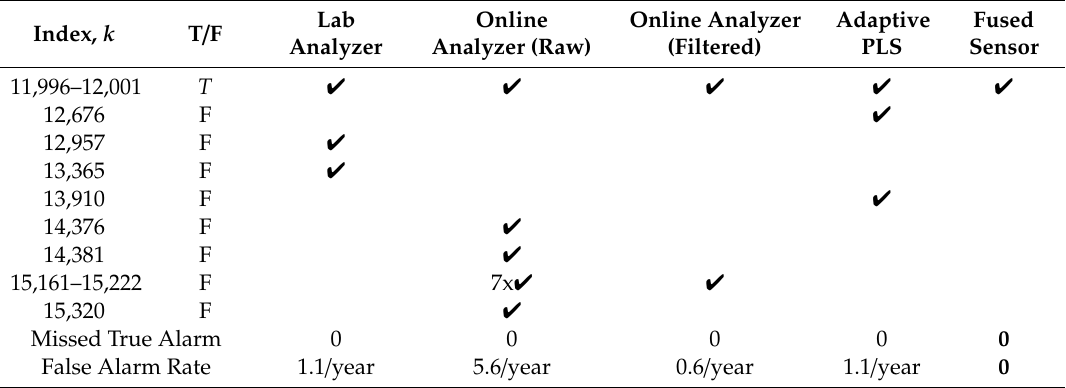
Table 3. Comparison of Sensors’ Detections for Impurity Alarms.